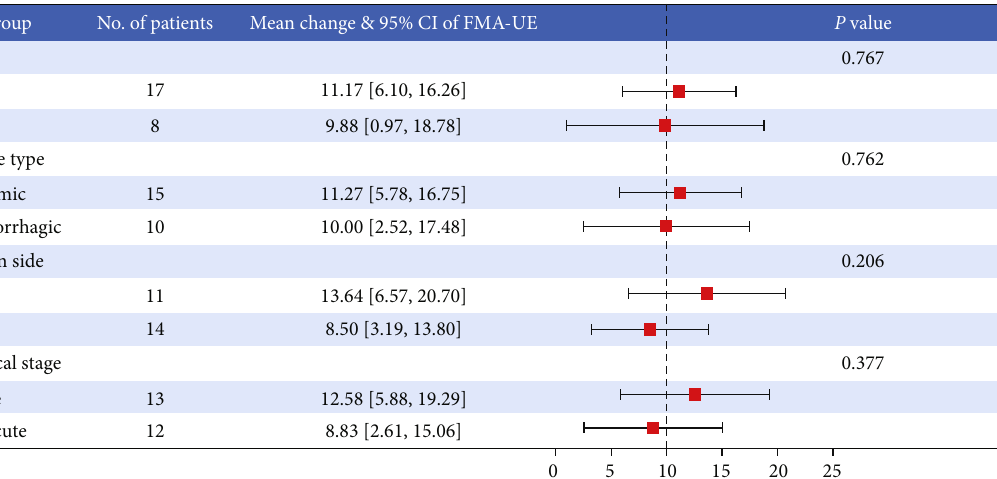
Figure 3: The subgroup analysis of age, stroke type, lesion side, and clinical stage. Clinical stage: Acute: < 1 month; Subacute: 1 to 3